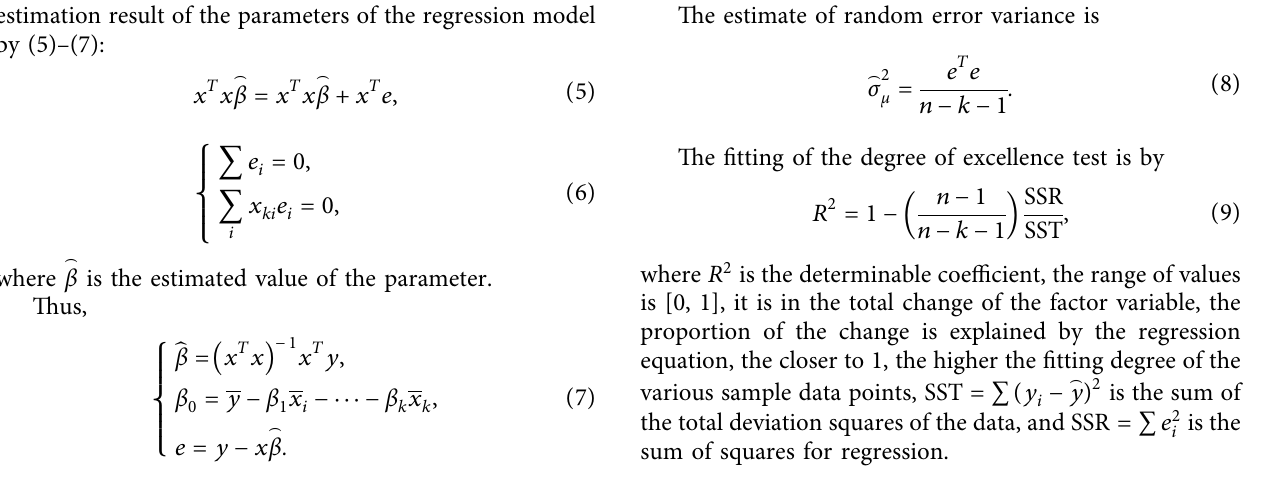
Figure 5: The polynomial regression